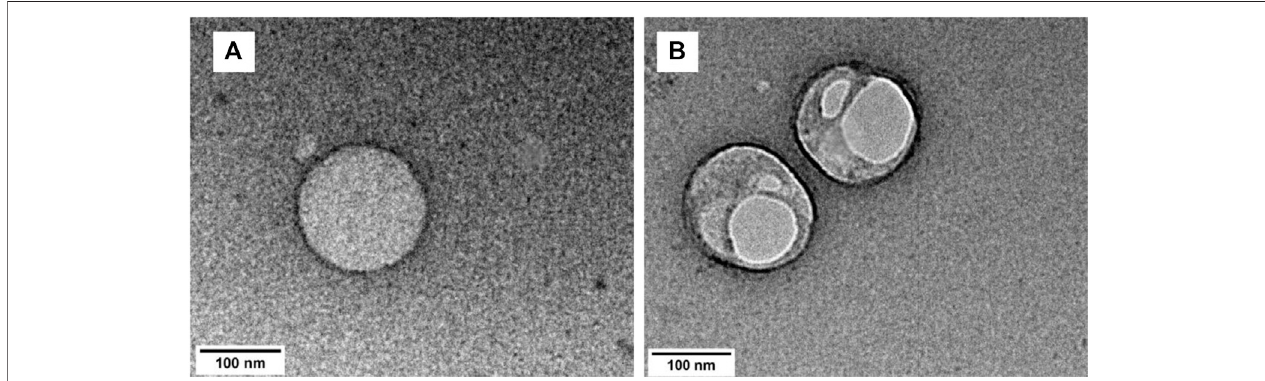
FIGURE 2 | TEM image of a TRPZ-bisMPA NPs (A) and TEM image of a TRPZ-127 NPs (B) in Milli-Q water from nanoprecipitation method. Additional images are provided in the SI.